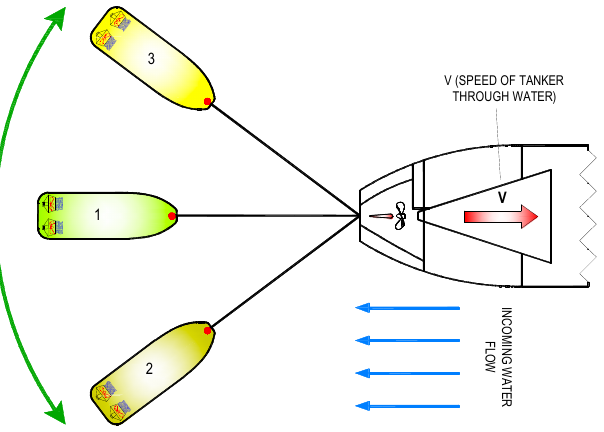
Figure 4. Direct reverse arrest mode by an ASD escort tug (0–6 knots). Drawing: Authors. At higher speeds, the propellers and main engines will experience an overload con- dition that increases rapidly, stalling the drives due to a negative flow of water through